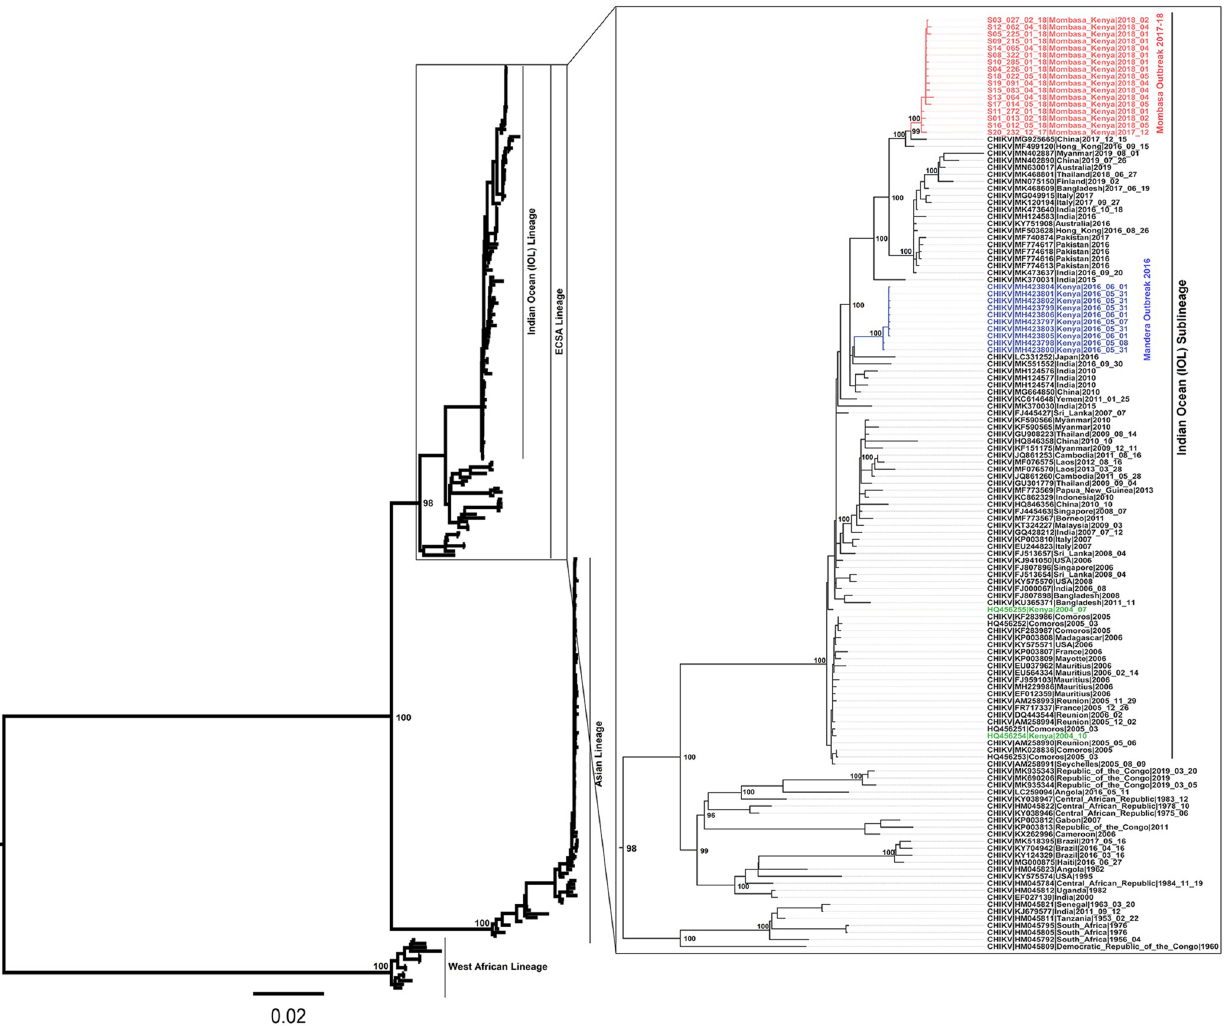
Fig 1. Maximum likelihood phylogenetic tree based on the complete-coding region of the four CHIKV lineages. The Mombasa 2017 outbreak genomes are highlighted in red and the Mandera outbreak strain is highlighted in blue. The Lamu/Mombasa 2004 strains are shown in green. The ECSA lineage with tip-labels is